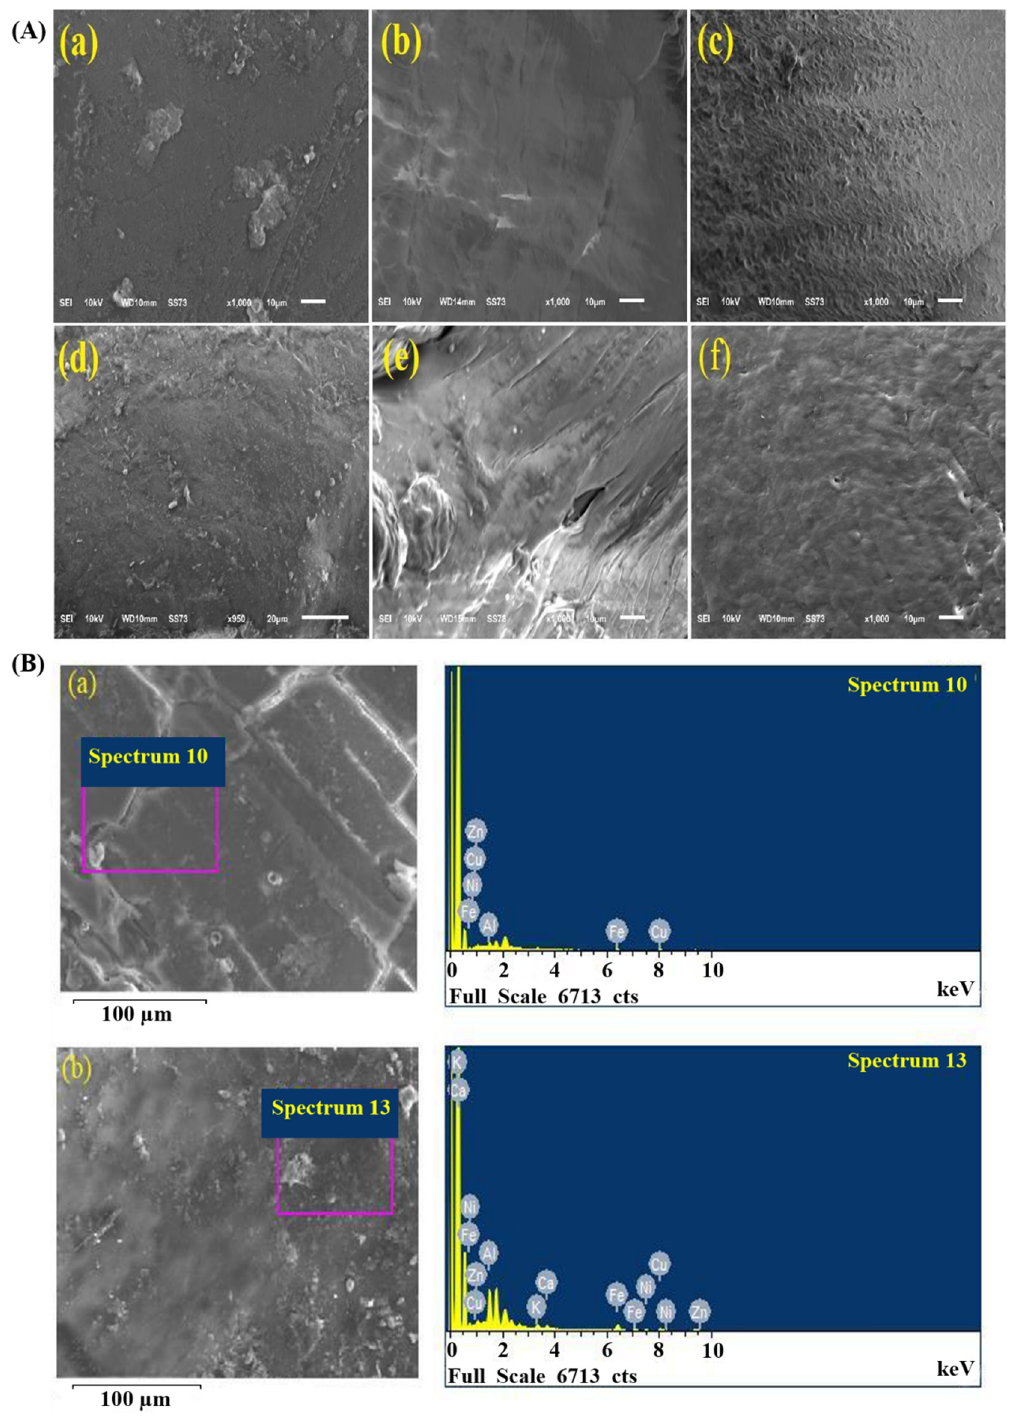
Figure 6. ( A ) SEM images of microplastics collected from the surface water and the surface sediments of Songshan Lake: (a) exfoliation; (b) linear crack; (c) granular oxidation; (d) adhering particles; (e) mechanical pits; and (f) solution pits; ( B ) SEM images and the corresponding EDS spectra of microplastics: microplastics fragments selected from (a) S1 and (b) S5.